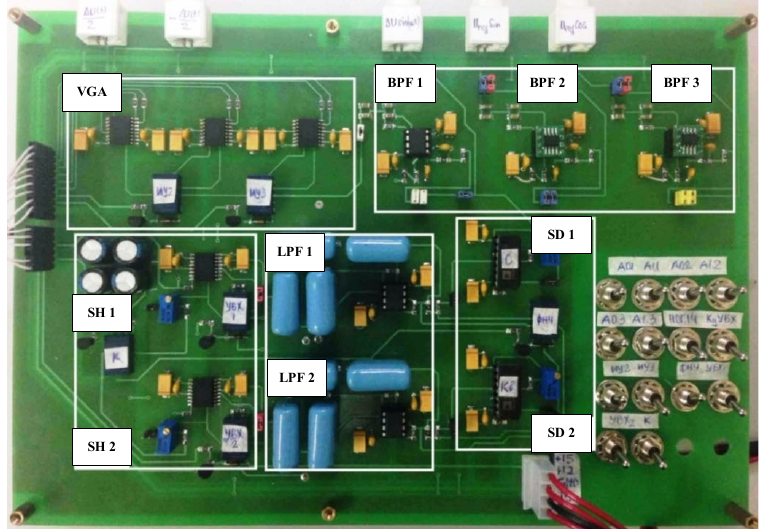
Figure 9. External view of the PCB of the developed lock-in amplifier model.